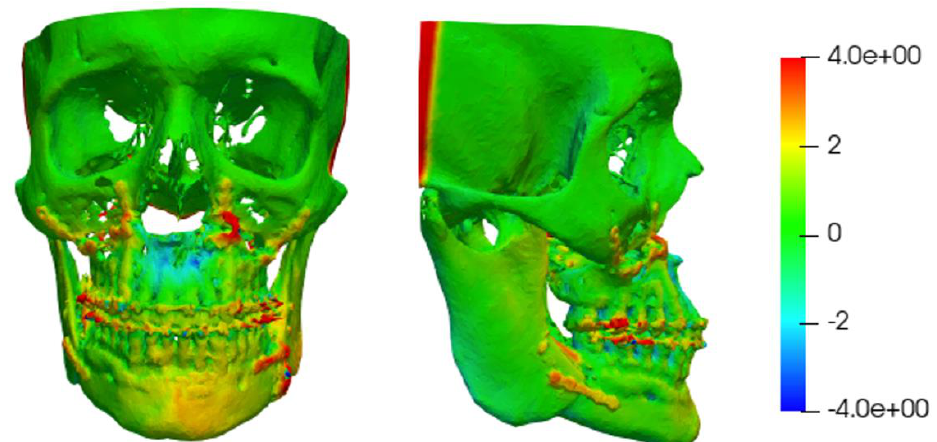
Figure 3. Color-coded maps of the distances (mm) in Paraview. A continuous color-coded scale was designed, where blue indicates negative distance differences and red positive distance differences.